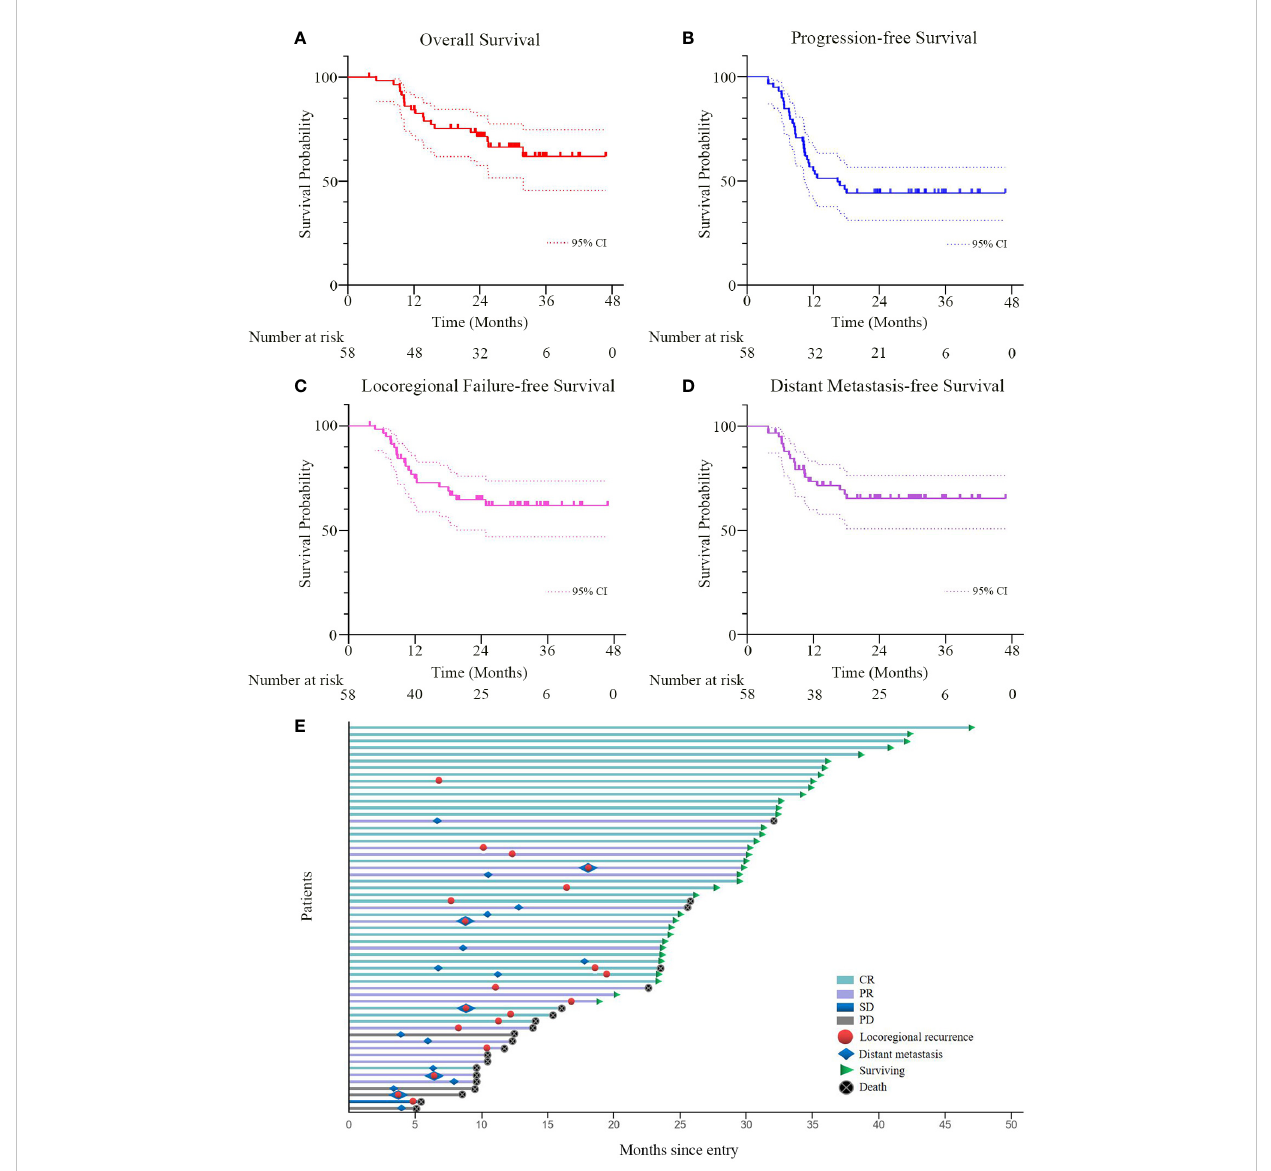
FIGURE 3 (A – D) Overall survival, progression-free survival, locoregional progression-free survival, and distant metastasis-free survival curves for all patients. The broken lines represent the upper and lower limits of the 95% CI of the survival curve, respectively. (E) Tumor swimmer plot for all patients. CR, PR, SD and PD were evaluated by the RECIST criteria based on CT, MRI, endoscopy and biopsy at six to eight weeks after the completion of CCRT. CCRT , concurrent chemoradiotherapy; RECIST , response evaluation criteria in solid tumors; CR , complete remission; PR , partial remission; SD , stable disease; PD , progressive